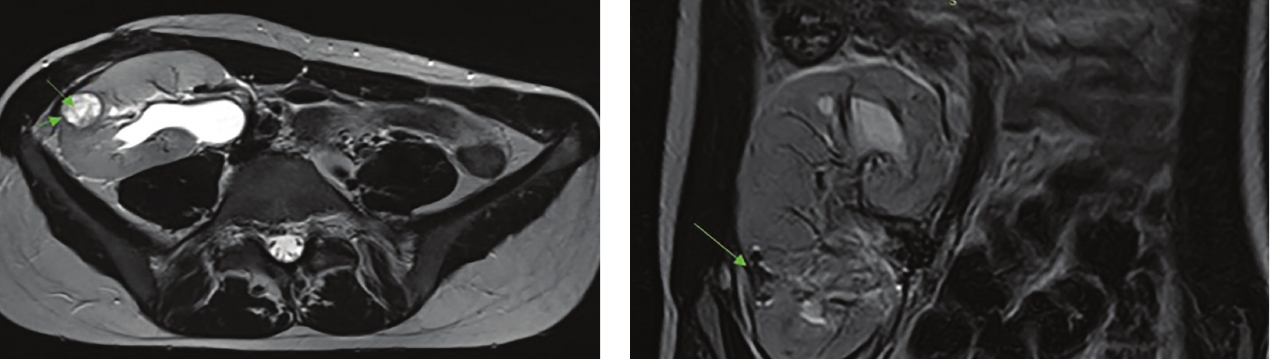
Figure 2 - Renal allograft after RFA, tumor with distinct borders (capsulated) with debris inside (necrosis)- marked with arrows